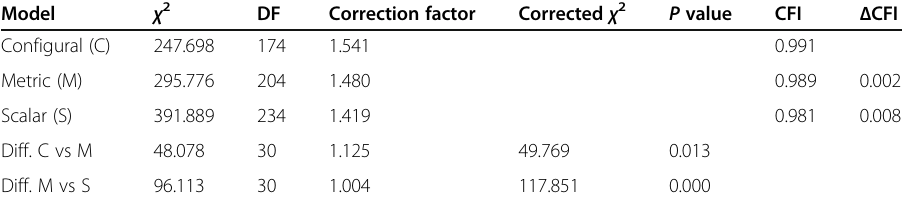
Table 8 Tests of cross-country measurement invariance — prolonged maternal feeding Model χ 2